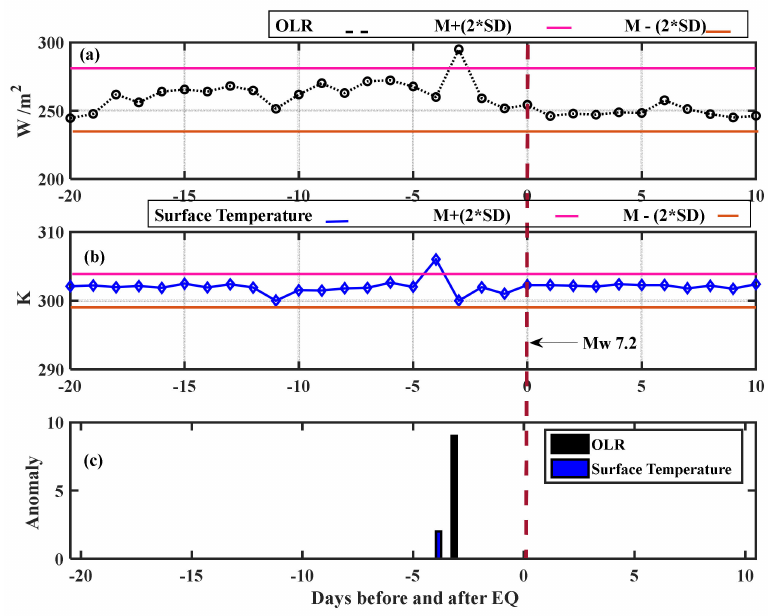
Figure 14. ( a ) OLR time series, ( b ) ST time series over the epicentral zone with upper and lower bounds of mean and standard deviation, ( c ) deviation of OLR time series values, and ST time series values from upper and lower bounds. The red dashed line indicates the EQ